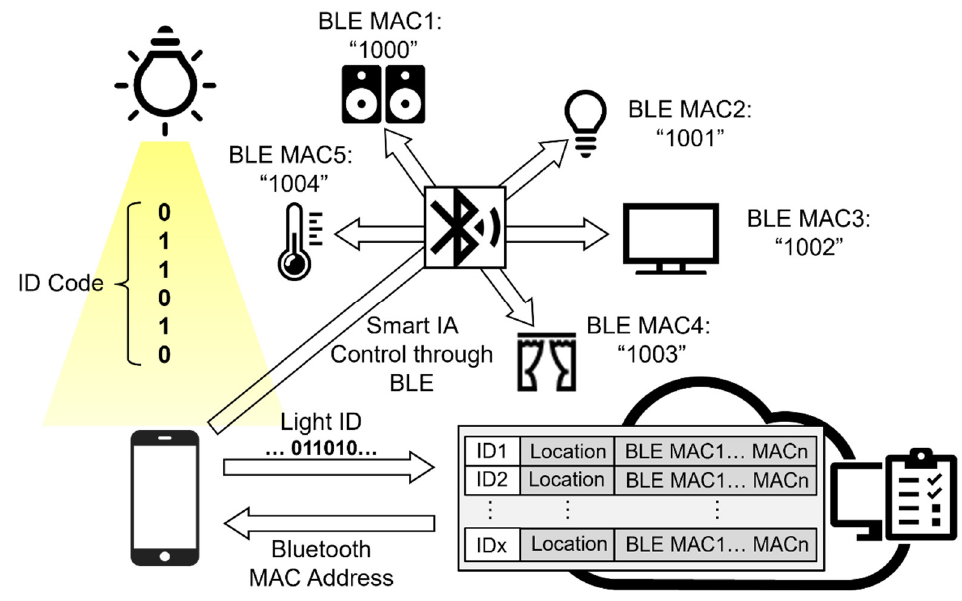
Figure 2. Architecture of proposed smart home control system.